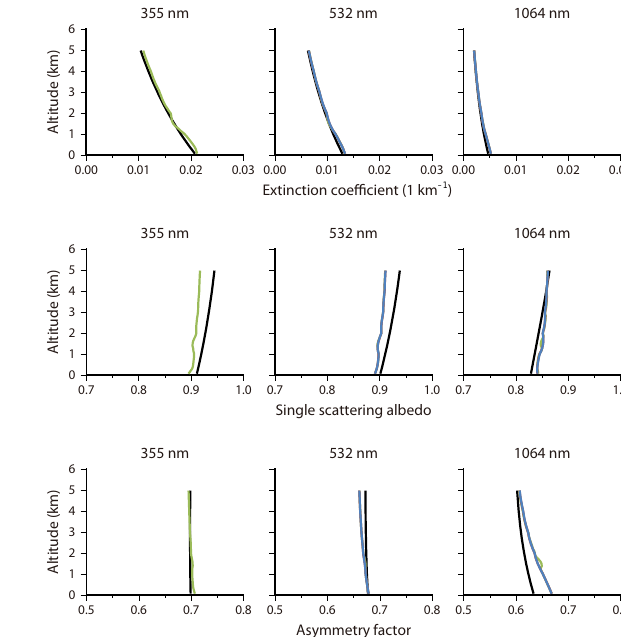
Figure 5. Retrieval results from the simulated data for the continen- tal average aerosol: the extinction coefficients, the single-scattering albedo, and the asymmetry factor. “True” values are shown by the black lines, and the colored lines indicate retrievals from Type 1 data set (MIEL data at 532 and 1064nm) (blue), Type 2 data set (MIEL data at 532 and 1064nm, and HSRL data at 532nm) (red), and Type 3 data set (MIEL data at 532 and 1064nm; HSRL data at 355 and 532nm) (green). The red and blue lines completely